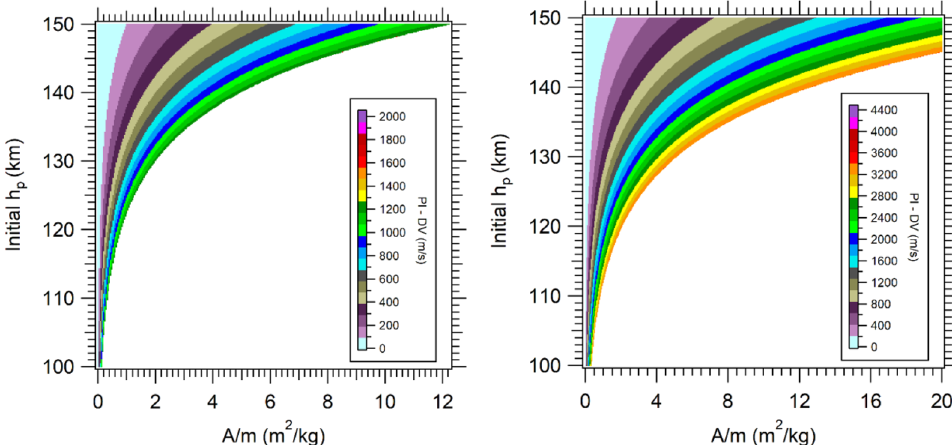
Figure 5. PI maps for V P = 0.246 VU (left), 0.336 VU (right).